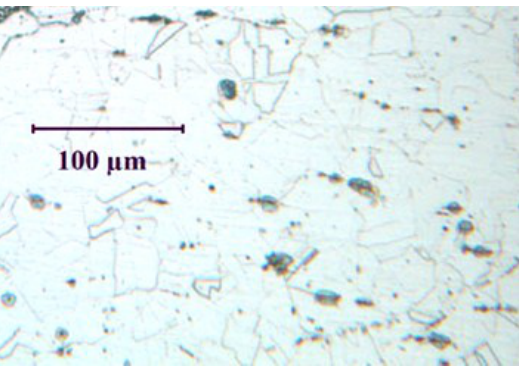
Figure 1. Etched microstructure of 316L stainless steel used in the present